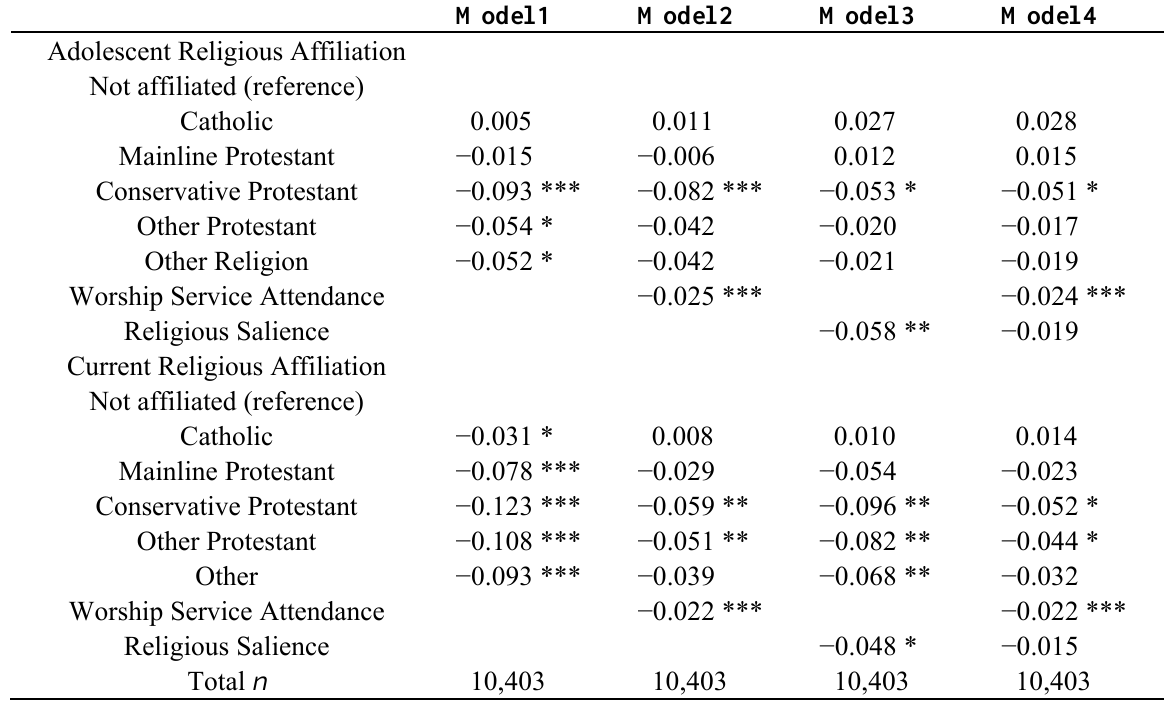
Table 3. Maximum Likelihood Parameter Estimates from Log-Logistic Survival (AFT) Regressions of Waiting Time on Religious Variables for